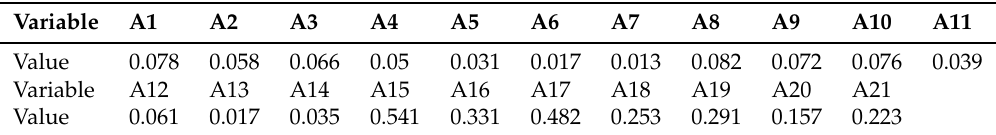
Table 2. Optimal membership function parameter values.